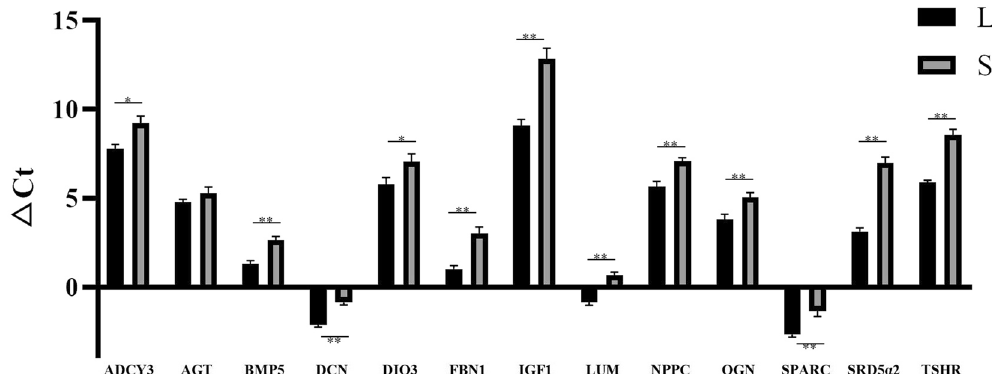
Figure 9. mRNA expression of the key 13 DEGs in large-knob geese and small-knob ones. Gene expression was characterized using RT-qPCR and was represented relative to β-actin. Mean △ Ct values of the small-knob group served as calibrators. Vertical bars represent the mean ± SD (n = 3). Significant differences relative to controls are indicated with one ( P < 0.05) or two ( P < 0.01) asterisks. The black and gray bar were large-knob geese and small-knob geese,